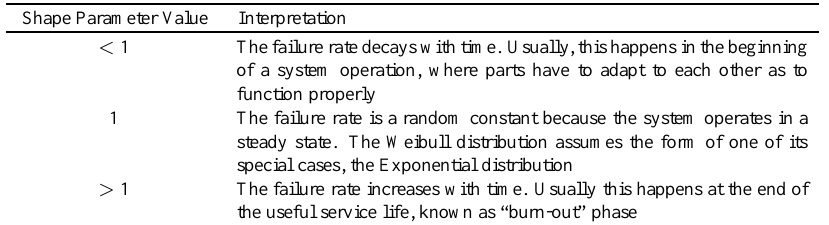
Table 2 Statistical interpretation of the Weibull shape